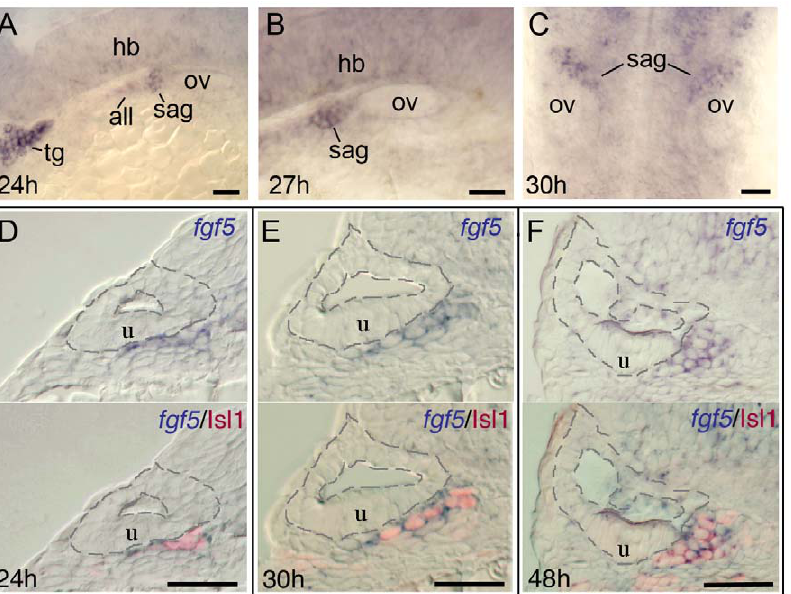
Figure 2. Mature SAG neurons express fgf5 . (A–C) Wholemount embryos showing lateral views of fgf5 expression at 24 hpf (A) and 27 hpf (B) and a dorsal view at 30 hpf (C). During these stages, fgf5 expression marks the trigeminal ganglion (tg), anterior lateral line ganglion (all) and SAG, and there is also weak diffuse expression in the developing hindbrain (hb). There is no detectable staining in the otic vesicle (ov). (D–F) Transverse sections (dorsal to the top and lateral to the left) of specimens co-stained for fgf5 (blue) and Islet-1 (red) at 24 hpf (D), 30 hpf (E) and 48 hpf (F). Sections pass through the middle portion of the SAG at the level of the utricular macula (u). The inner and outer surfaces of the otic vesicle are outlined. Co-labeling confirms that fgf5 expression in the SAG is restricted to mature neurons. Scale bar, 25 m m. During mid-somitogenesis stages fgf5 is diffusely expressed throughout the neural tube and strongly marks the developing trigeminal ganglion (not shown).